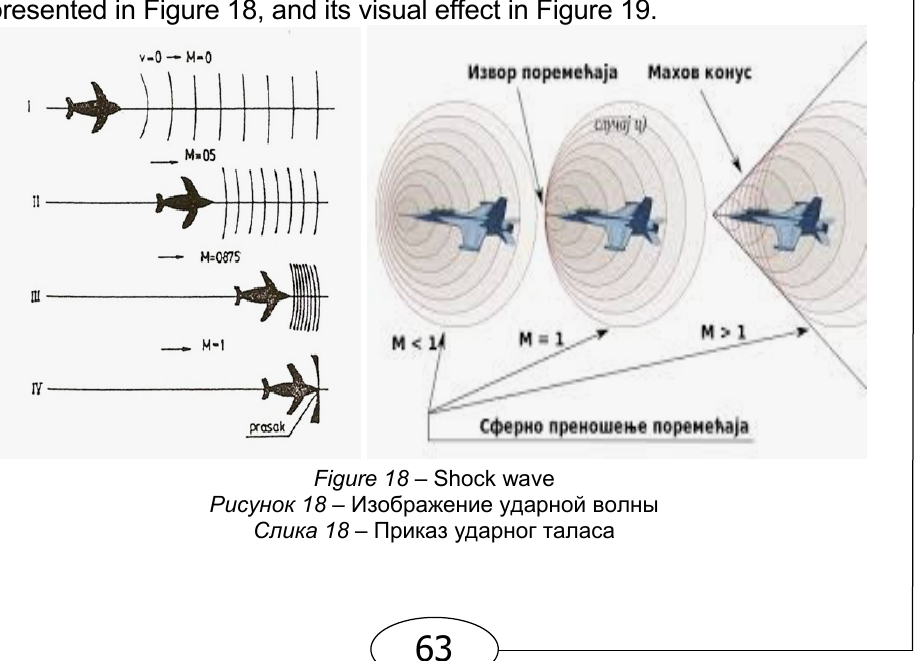
Figure 18 – Shock wave Рисунок 18 – Изображение ударной волны Слика 18 – Приказ ударног